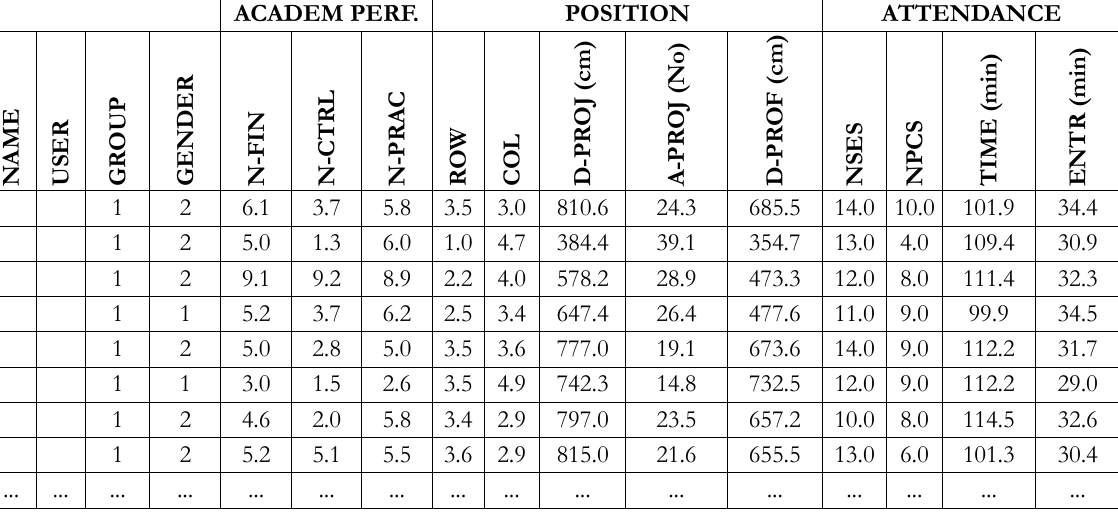
Table 4. Total set of variables and data related to each